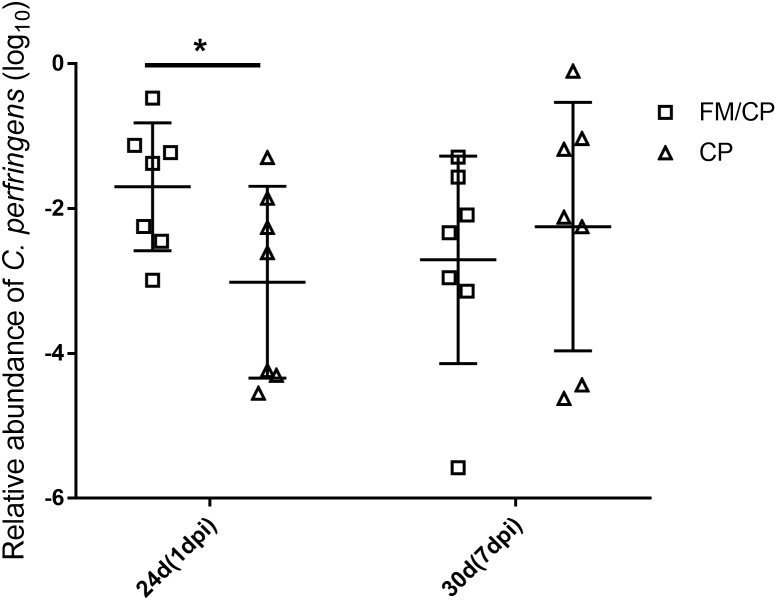
Viable relative abundance of Clostridium perfringens in the jejunum–ileum lumen. FM/CP and CP groups at day 20 and group FM remained negative for C. perfringens throughout the study. No significant differences between group FM/CP and CP at day 30 were observed (∗p > 0.05; ANOVA).